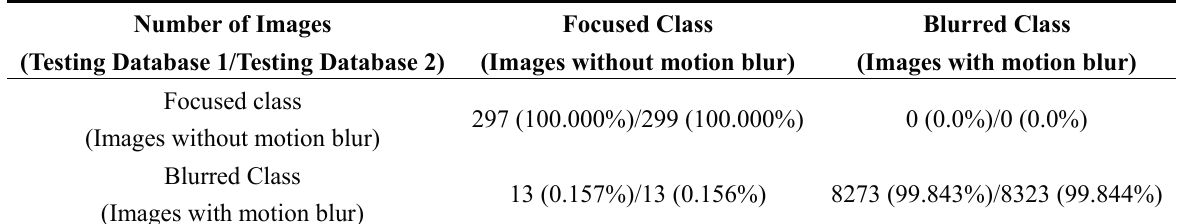
Table 10. Classification results of images into focused and blurred classes for two testing databases using new motion blur database obtained from MORPH database.